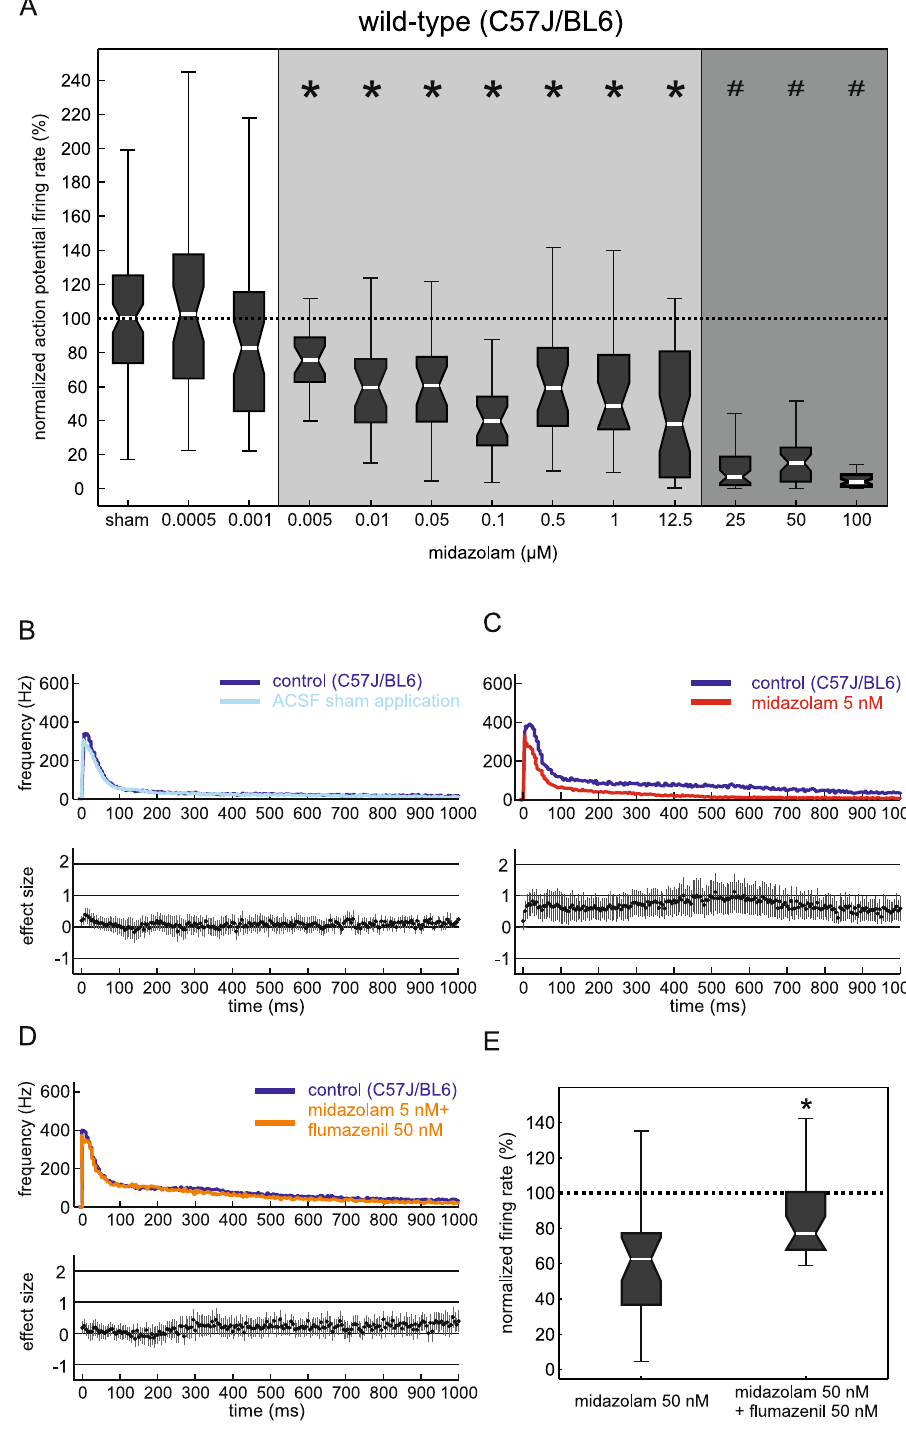
Figure 2. The effects of midazolam on global neuronal activity. ( A ) Midazolam inhibited the action potential firing rate of neocortical cultures in a biphasic manner. Over a wide concentration range starting at 5 nM up to 12.5 μ M the residual activity roughly averaged 60% ( * p < 0.001 compared with ACSF sham application, light grey). When increasing the concentration to 25 μ M a further depression was observed, statistically different compared with the former concentration range ( # p < 0.001, dark grey) (n/concentration: 27–50). All data are normalized to the median of the ACSF sham application. The dotted line marks 100%, i.e. no difference compared to ACSF sham application (statistical analysis: Kruskal-Wallis test with post-hoc analysis (Bonferroni) and Mann-Whitney U test for testing between two different groups). ( B – D ) Effects of midazolam on neuronal up states displayed as peri-event time histogram (PETH). To illustrate the differences, the